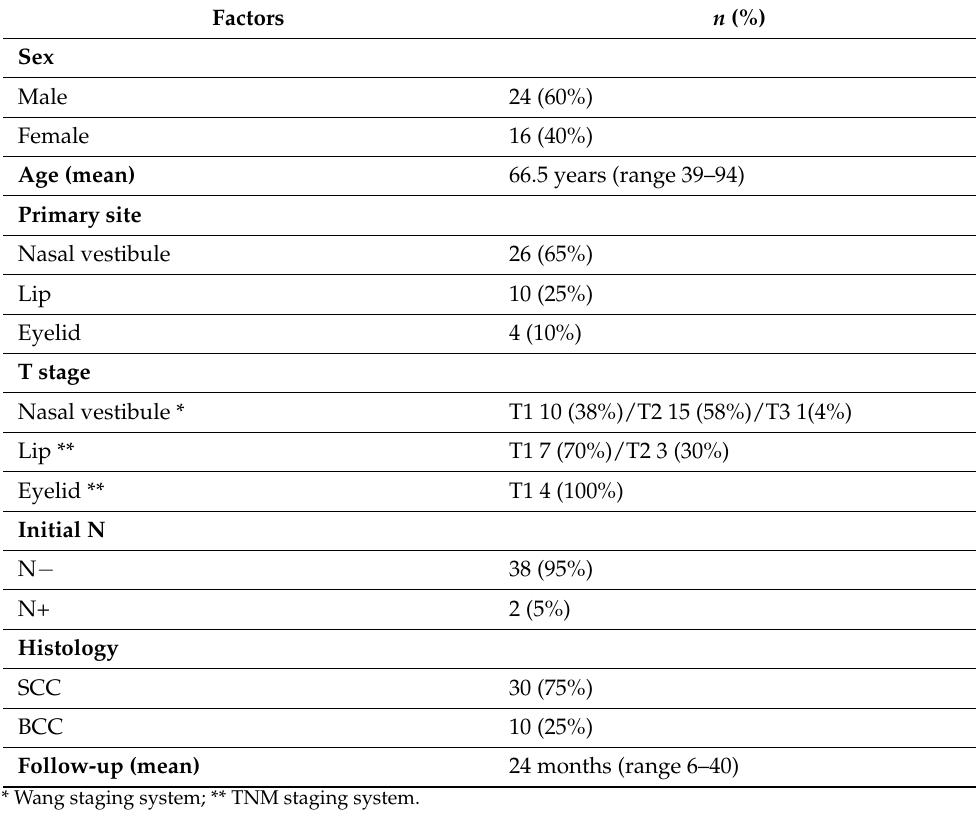
Table 1. Patients’ characteristics.